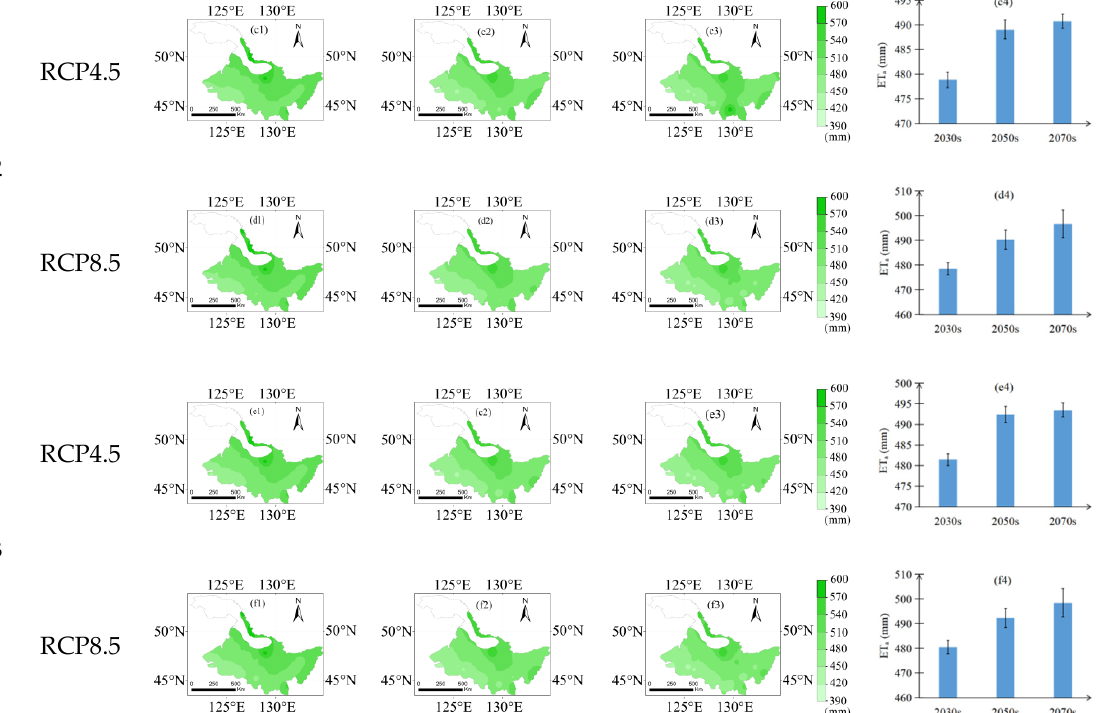
Figure 7. Spatial and temporal distribution of maize ET a for the multi-GCM ensemble under different irrigation schedules (( a1 – a4 , b1 – b4 ) W1, ( c1 – c4 , d1 – d4 ) W2,( e1 – e4 , f1 – f4 ) W3) in the 2030s, 2050s, and 2070s with two RCPs.